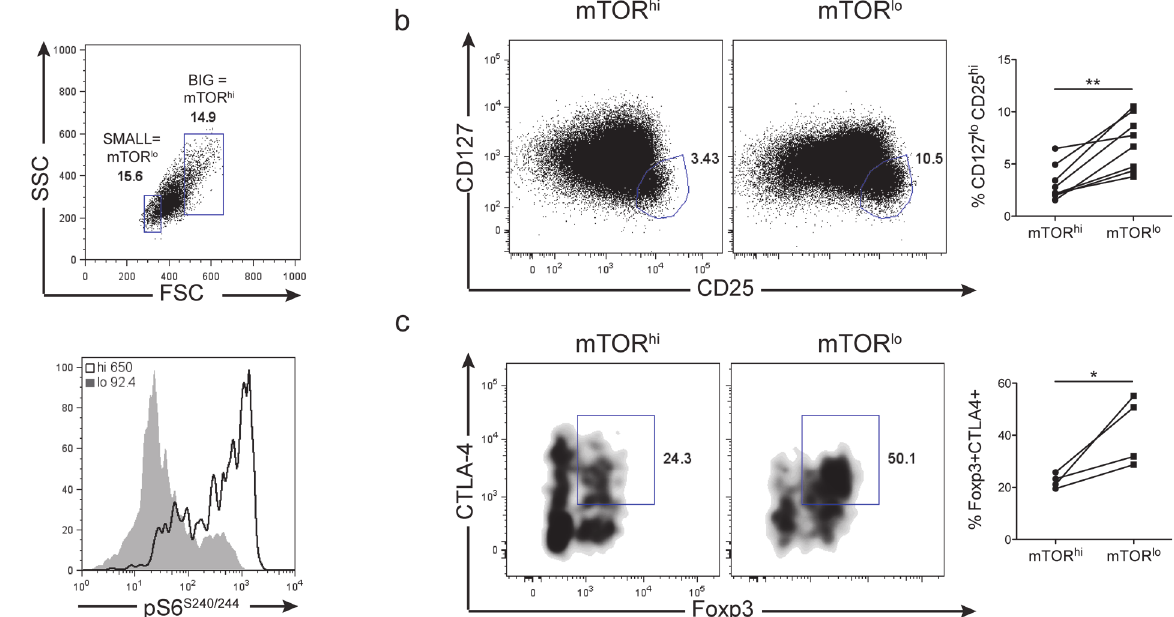
Fig 8. Cellular size (indicative of mTORC1 activity) influences the phenotype of human CD4+ T cells similar to mouse. CD4+ T cells were purified from the PBMCs of 8 human volunteers. Cells were stimulated with human anti-CD3 and anti-CD28 activator beads overnight. a) 24hrs after stimulation, mTORC1 activity was assessed by the pS6 expression of the 15% largest and smallest activated (HLA-DR+) CD4+ T cells. Histograms in the lower FACs plot were determined from the ‘ big ’ and ‘ small ’ gates shown in the upper plot. The pS6 MFI is shown in the upper corner of the FACs plot. b-c) 24hrs after stimulation, the cells were sorted from the 15% largest and smallest activated (CD38+) CD4+ T cells. Sorted populations were cultured in media supplemented with human IL-2 for 72 hrs. After 72 hrs, the phenotype of the large ‘ mTOR hi ’ and small ‘ mTOR lo ’ populations was assessed by flow cytometry. b) Human T-reg populations were determined from the CD127 lo CD25 hi gating strategy. c ) FACs plots show percentage of Foxp3+ CTLA-4+ double positive cells gated from the ‘ T-reg ’ gate in b. Statistics are shown to the right. The connecting lines demonstrate the changes in percentages between the mTOR hi and mTOR lo sorted populations from the same individual. The data are representative of 8 distinct human